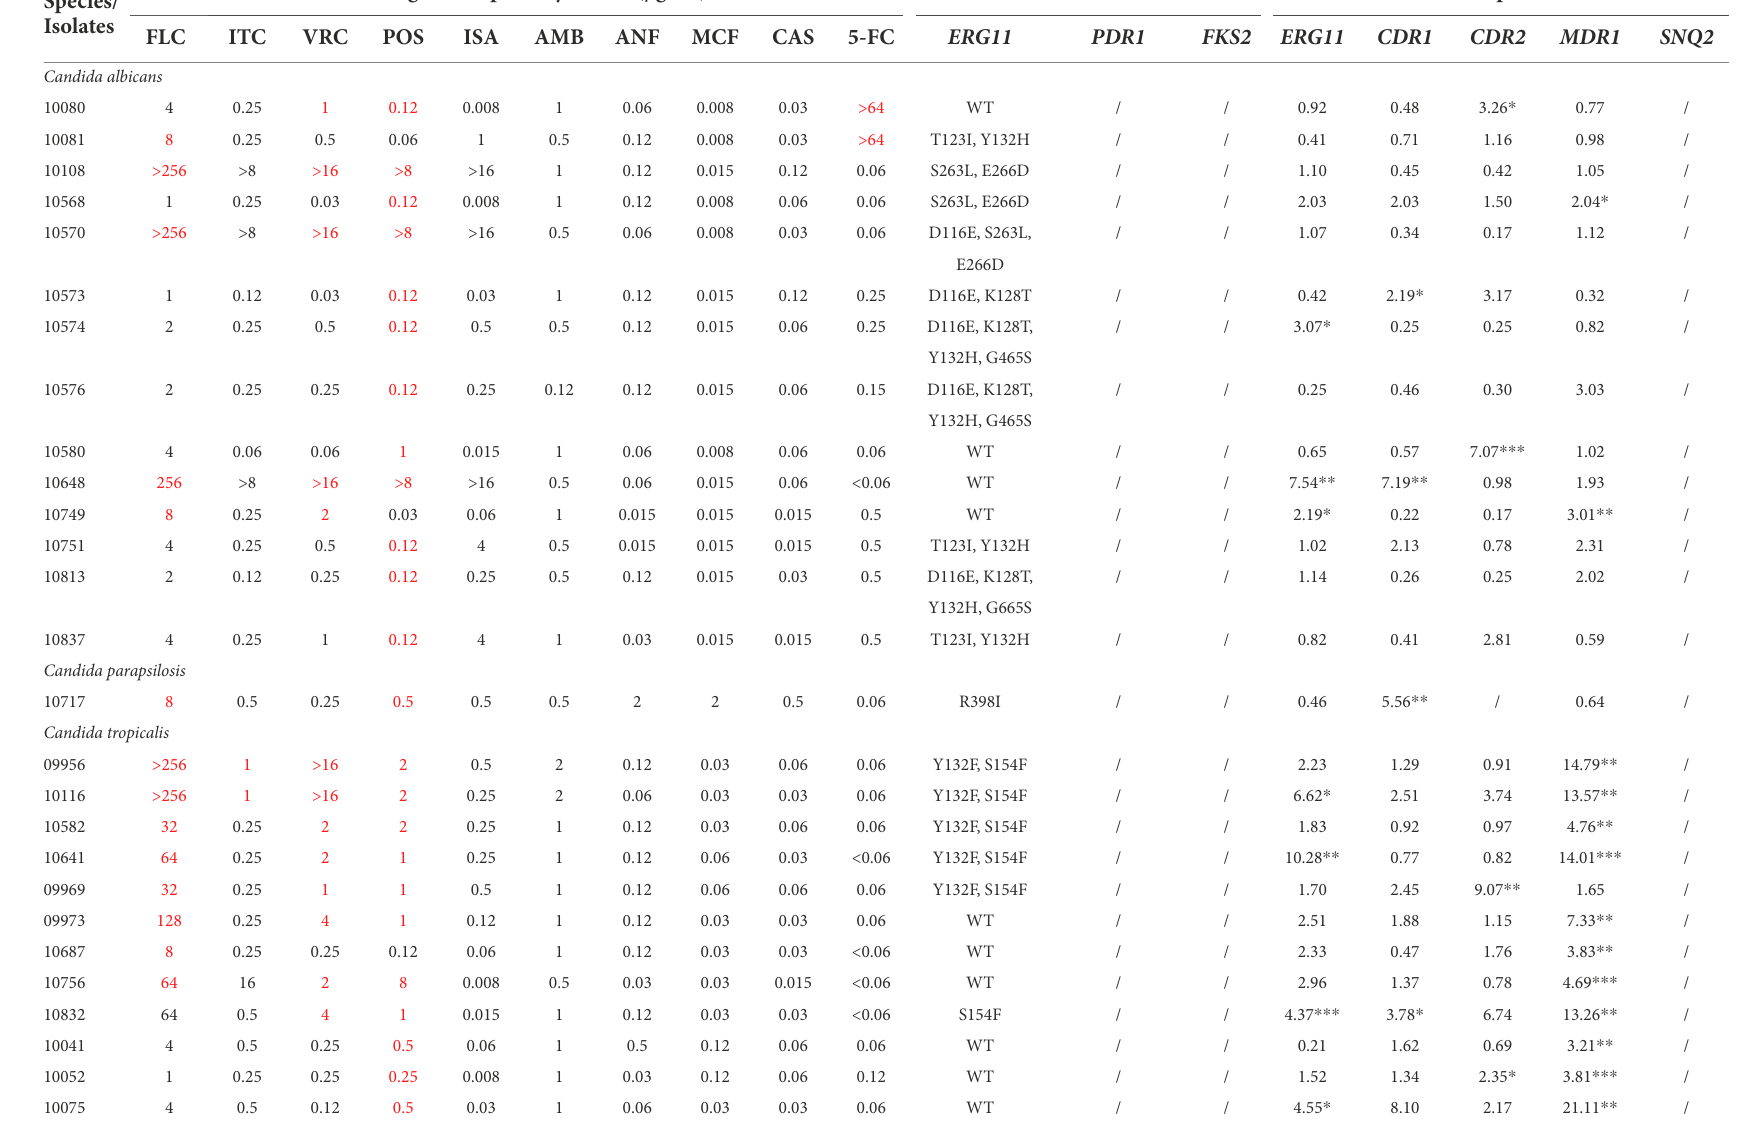
TABLE 3 Mutations and expression level of resistance-related genes in resistant/NWT Candida isolates.